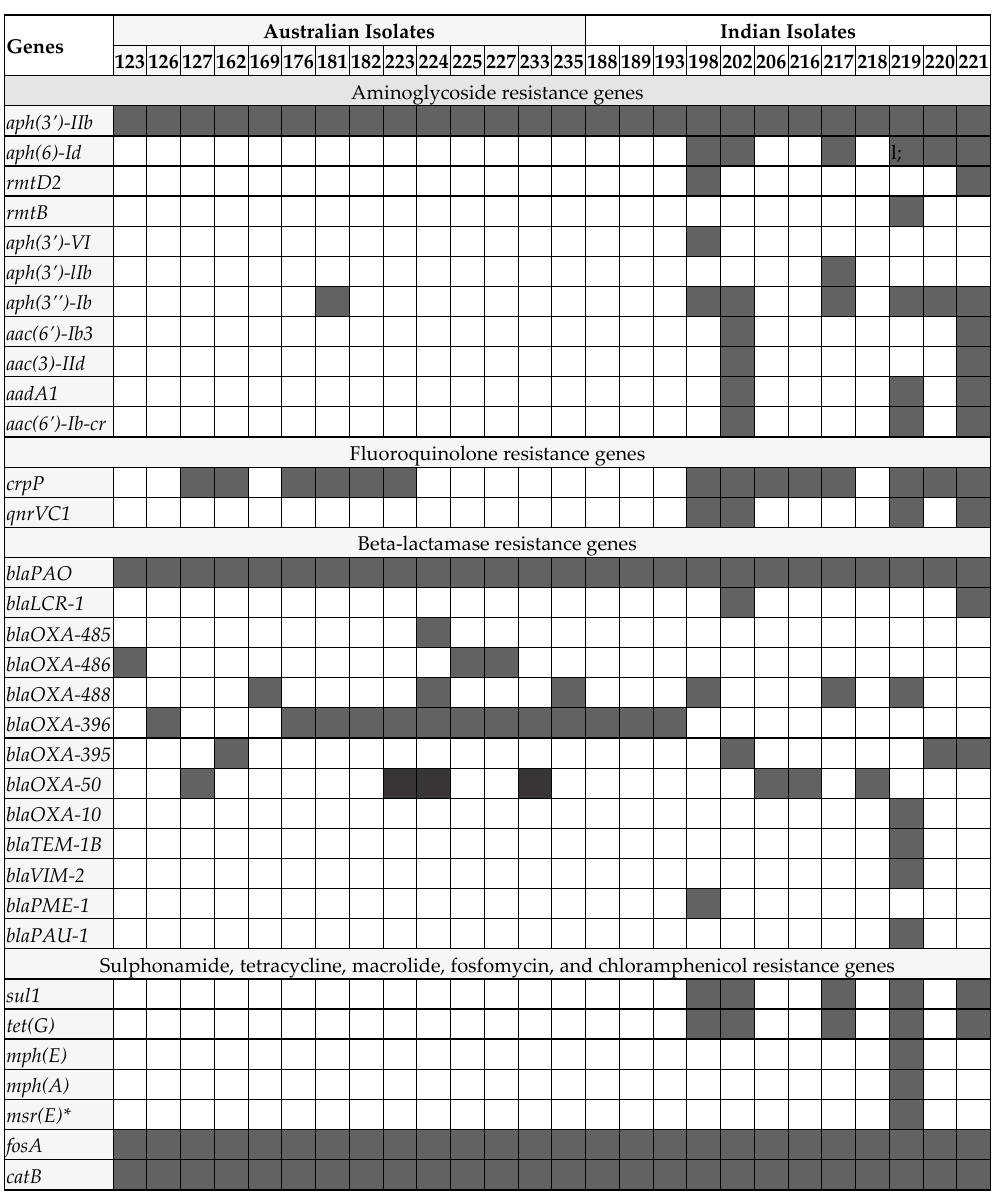
Table 2. Acquired resistance genes in P. aeruginosa isolates from India and Australia.